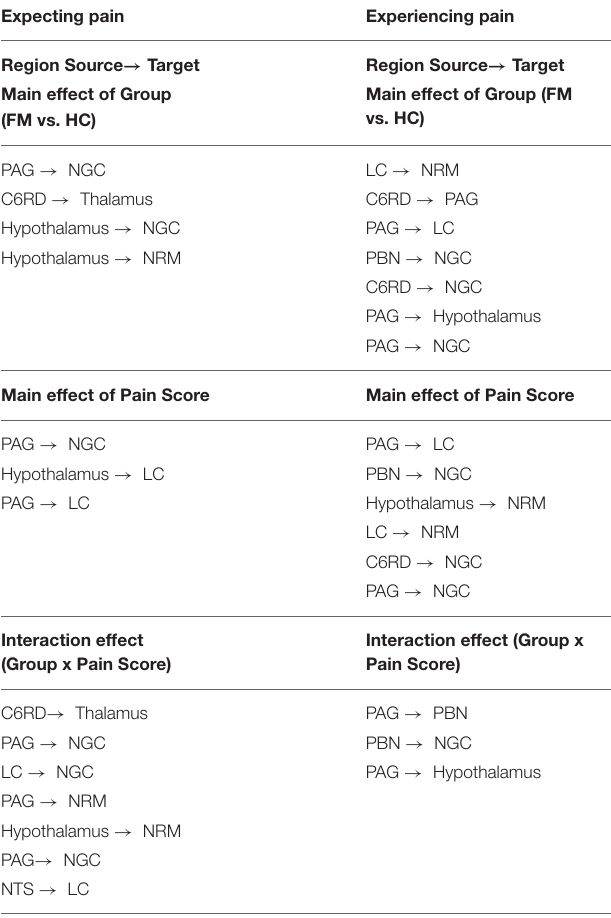
TABLE 5 | ANCOVA results for both the Expectation and Stimulation epochs, comparing main effects of group (FM vs. HC), main effects of normalized pain scores, and group x pain score interaction